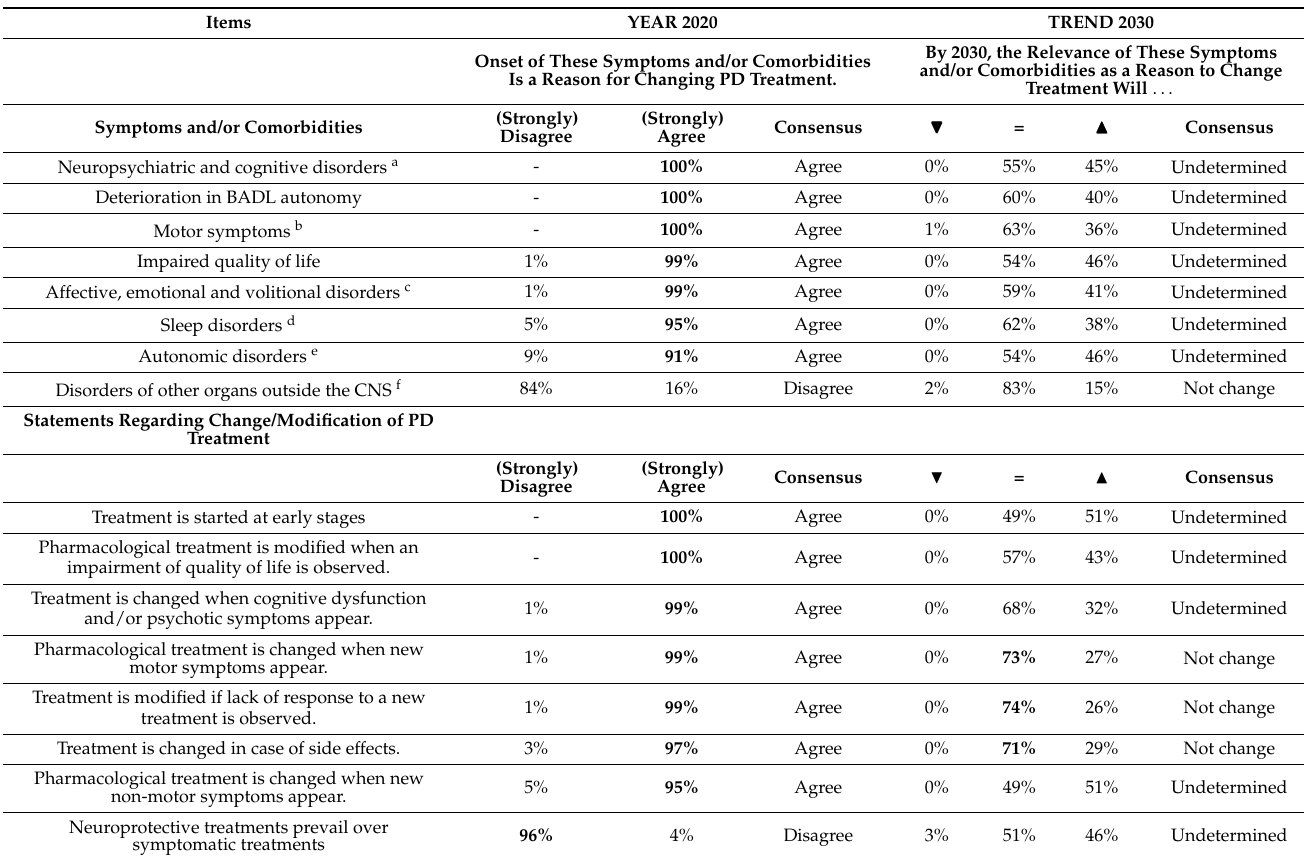
Table 5. Change/modification of PD treatment: present and